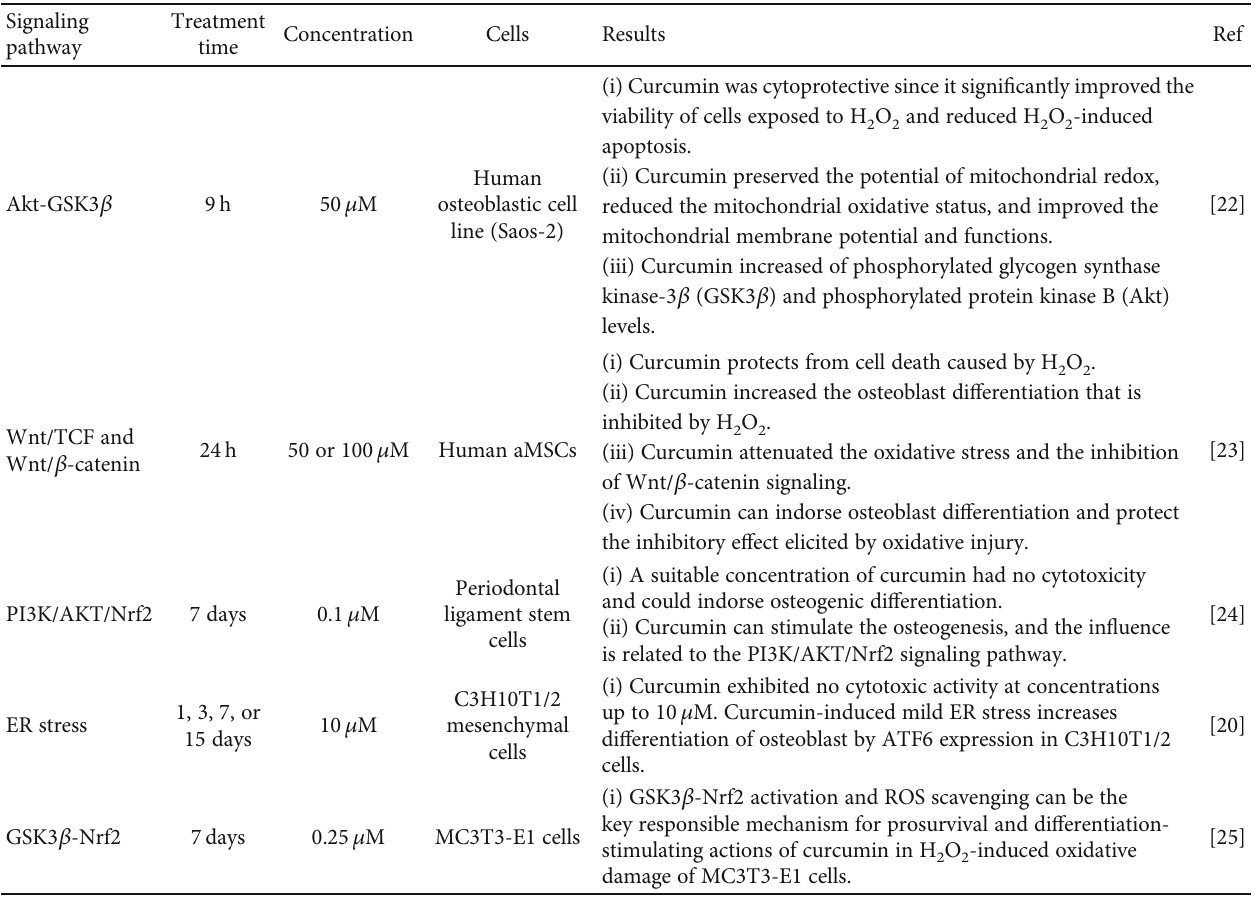
Table 1: The protocols of curcumin use in cell culture in several signaling